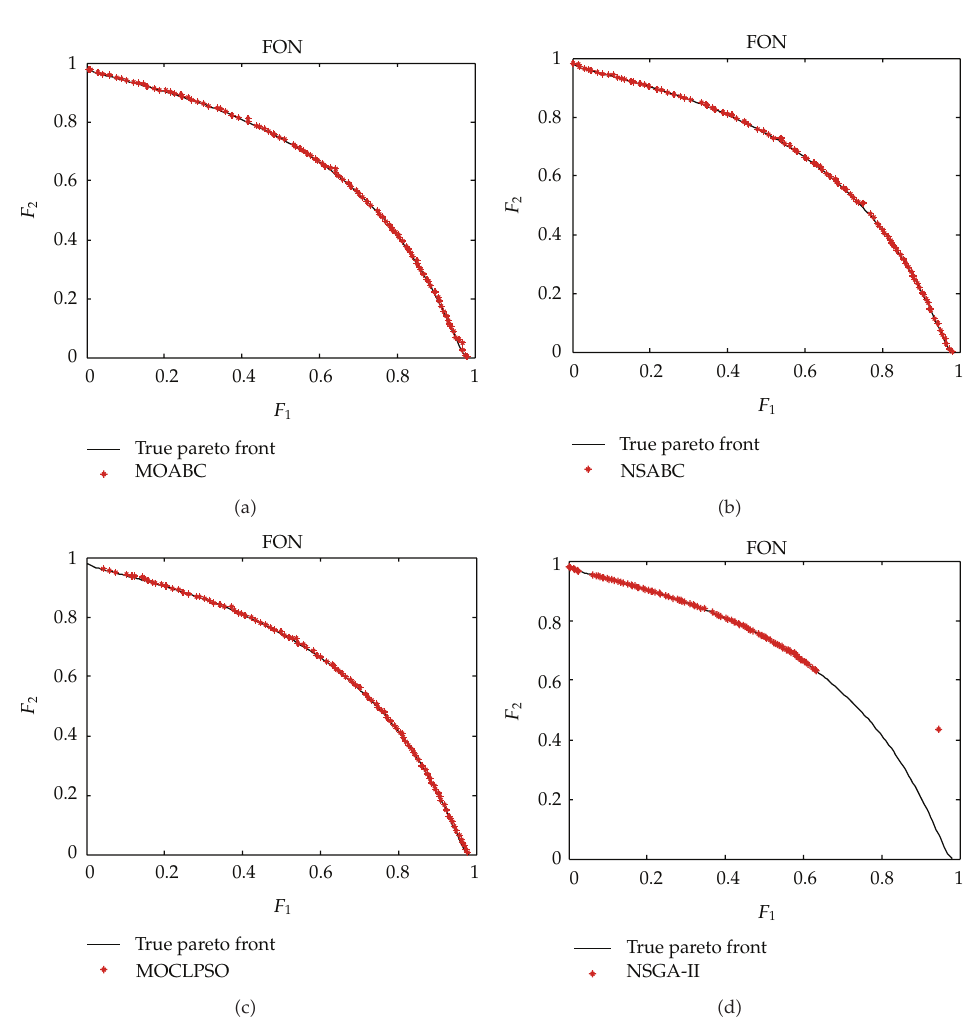
Figure 7: Pareto fronts obtained by NSABC, MOABC, MOCLPSO, and NSGA-II on FON after 20000